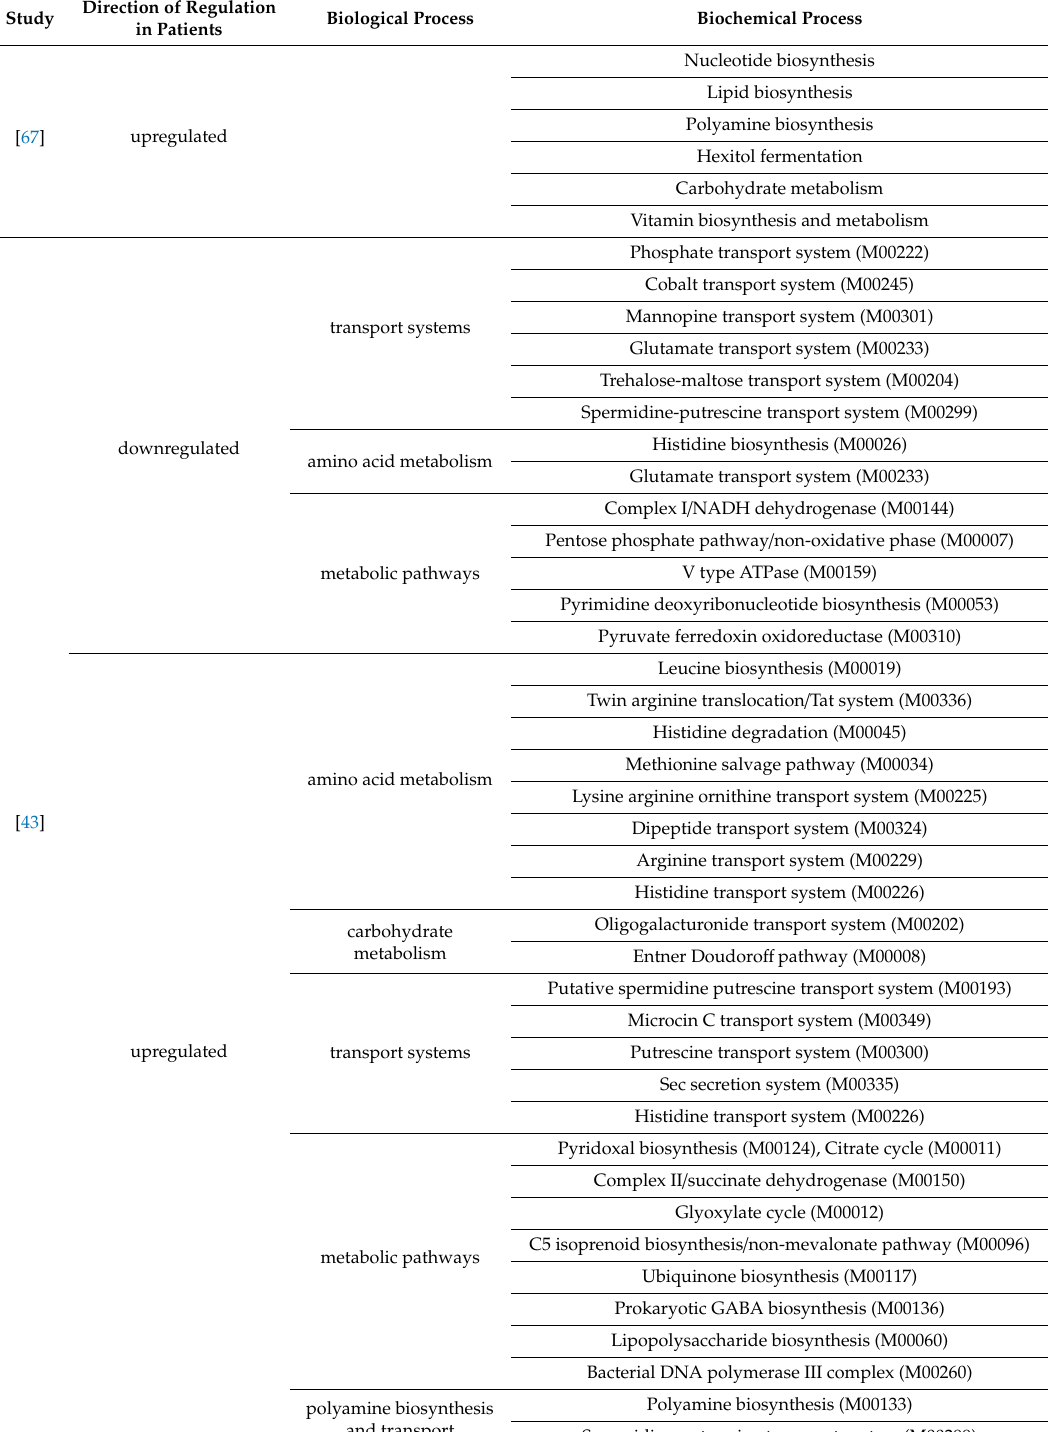
Table 3. Bacterial metabolic pathways dysregulated in pancreatic